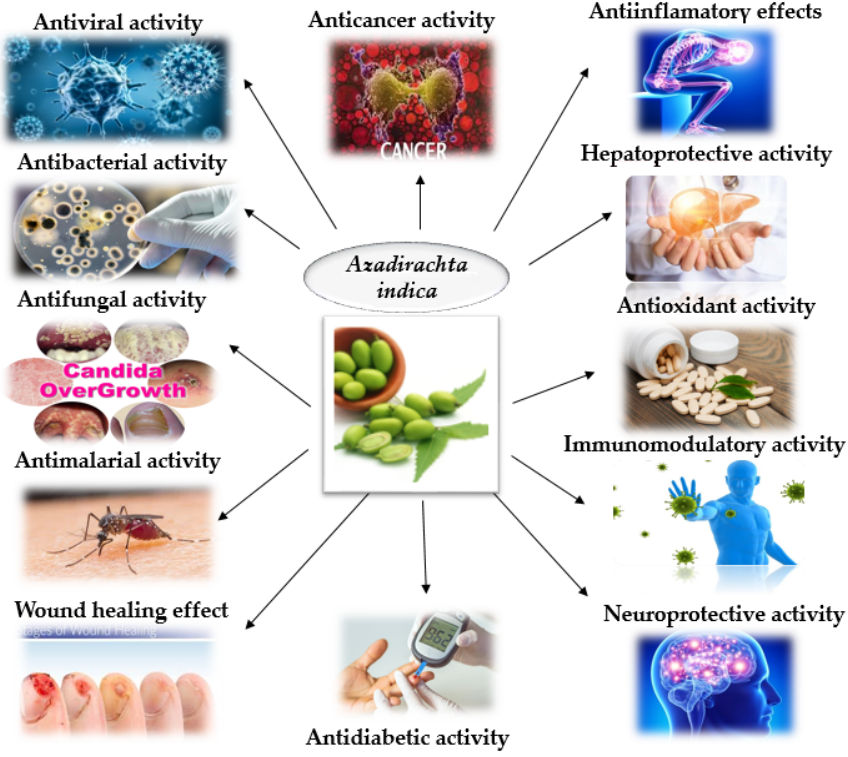
Figure 2. The beneficial activity of neem in general health, disease prevention, and treatment (adapted from Tiwari [26]).